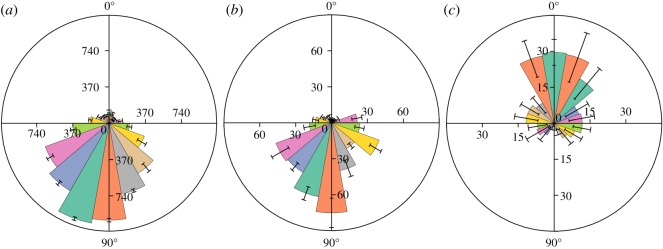
Distribution of crack plane orientation for tensile cracks in different simulation tests: (a) UCS, (b) Brazilian test and (c) direct tension test (10 numerical specimens with different bond strength distributions).